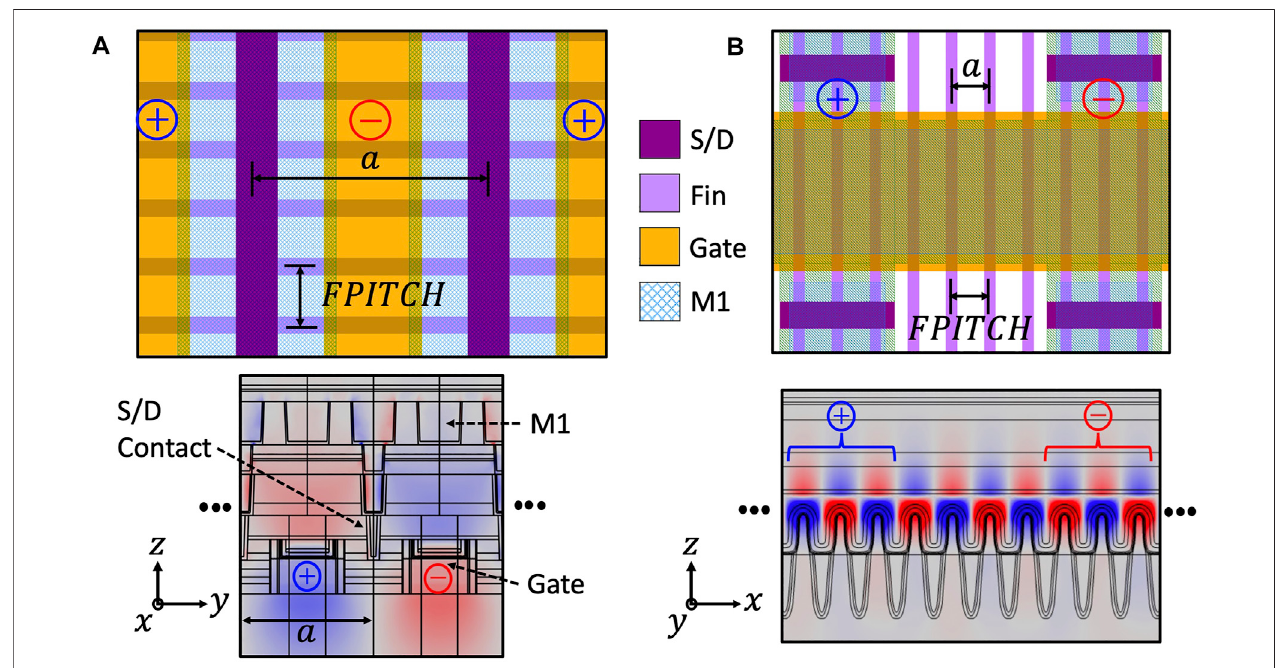
FIGURE6|(A) Layoutandy-stressplotforapairofunitcellsinan11.8 GHzFinResonantBodyTransistor(fRBT)deviceinGF14LPP. (B) Layoutandy-Stressplot for a 32 GHz Resonant Fin Transistor (RFT) device in GF14LPP depicting the 3-skip-4 drive transducer con fi guration.